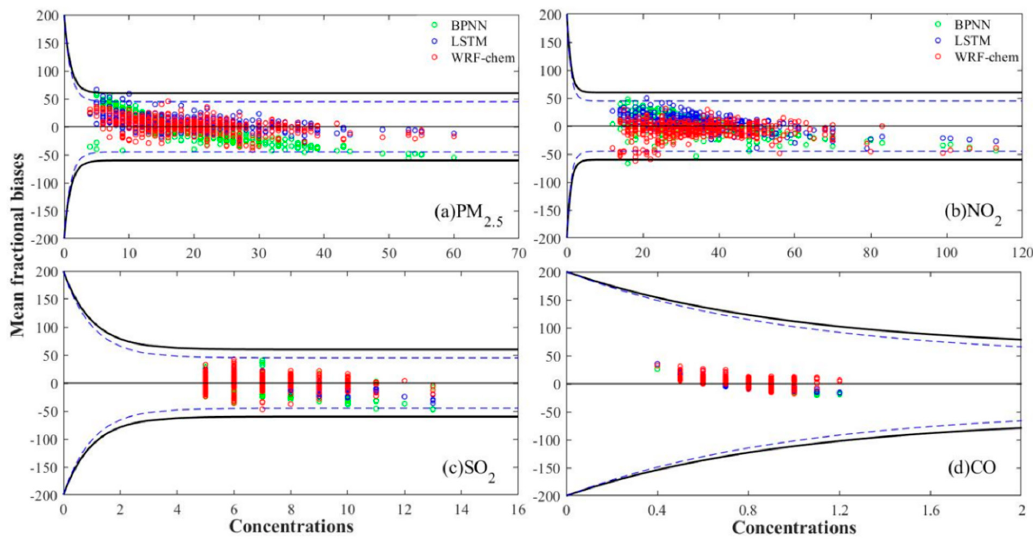
Figure 10. Mean fractional biases in the ( a ) PM 2.5 , ( b ) NO 2 , ( c ) SO 2 , and ( d ) CO concentrations for all model simulations compared with the criteria (black solid lines) and expected goals (blue-dashed lines). The concentration units were μ g m -3 , μ g m -3 , μ g m -3 , and mg m -3 , respectively. Red circles represent the WRF-Chem simulations, blue circles represent the LSTM simulations, and green circles represent the BPNN simulations.